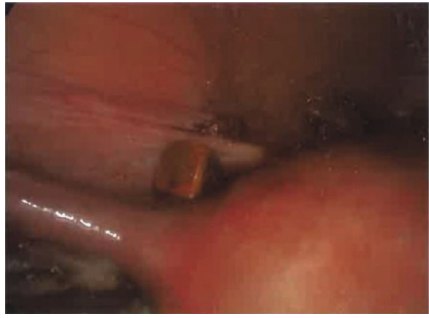
Figure 2: Stone-like material deeply embedded in peritoneum.